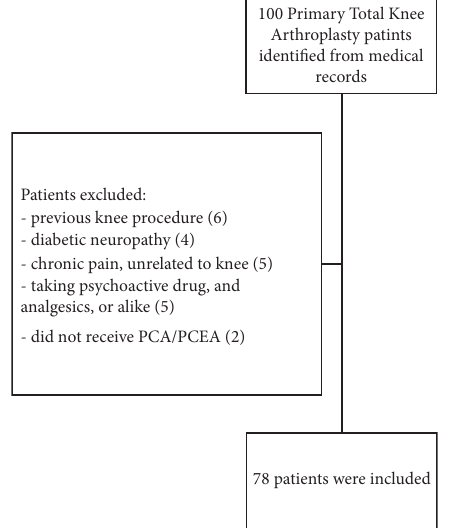
Figure 1: The flow diagram of the study patients’